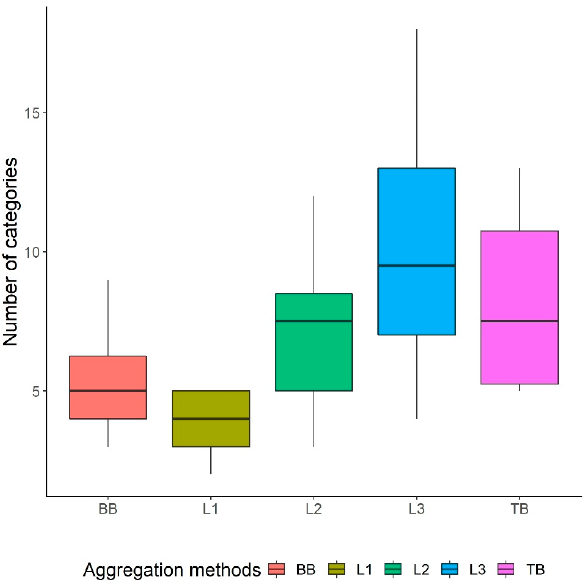
Figure 4. Number of categories in the calibration interval in the whole dataset by aggregation method (BB = Behavior-based aggregation; L1 = Corine Standard Level 1 aggregation; L2 = Corine Standard Level 2 aggregation; L3 = Corine Standard Level 3 aggregation; TB = Threshold-based aggregation). BB, L1, L2, L3 and TB groups include 24,24,24,24 and 18 model runs, respectively. The vertical middle line shows the median, the box boundaries show the first and third quartiles of the method, the lower and upper end of whiskers show the minimum and maximum values of the method.